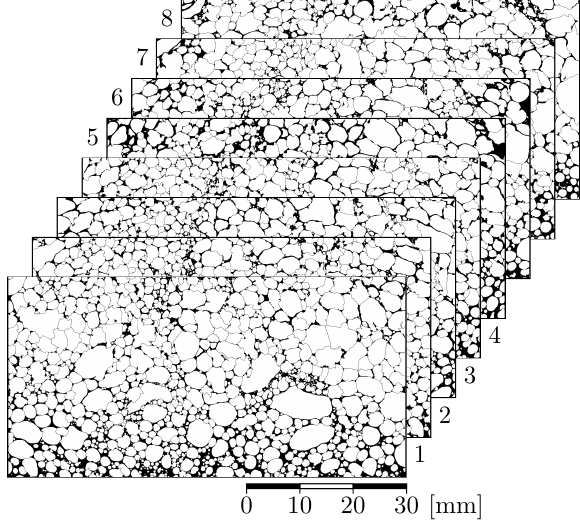
Figure 5. Automatic Tile Design, a) square samples with the edge size l , b) arranged sam- ples overlapping by ω , c) final cut-out tile created by IQA.